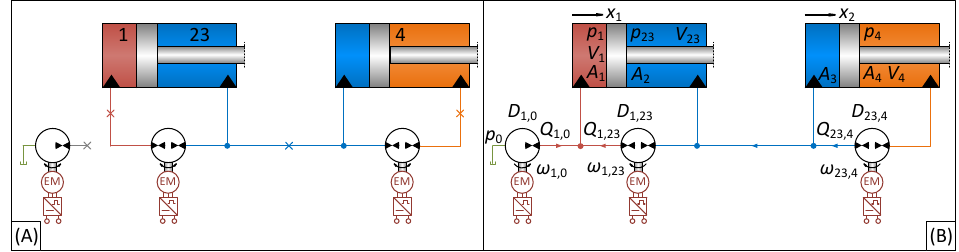
Figure 13. ( A ) Example of interconnection scheme for linear VDN topology; ( B ) specific interconnec- tion scheme 0 ↔ 1 ↔ 23 ↔ 4 for linear VDN topology with shared chambers.